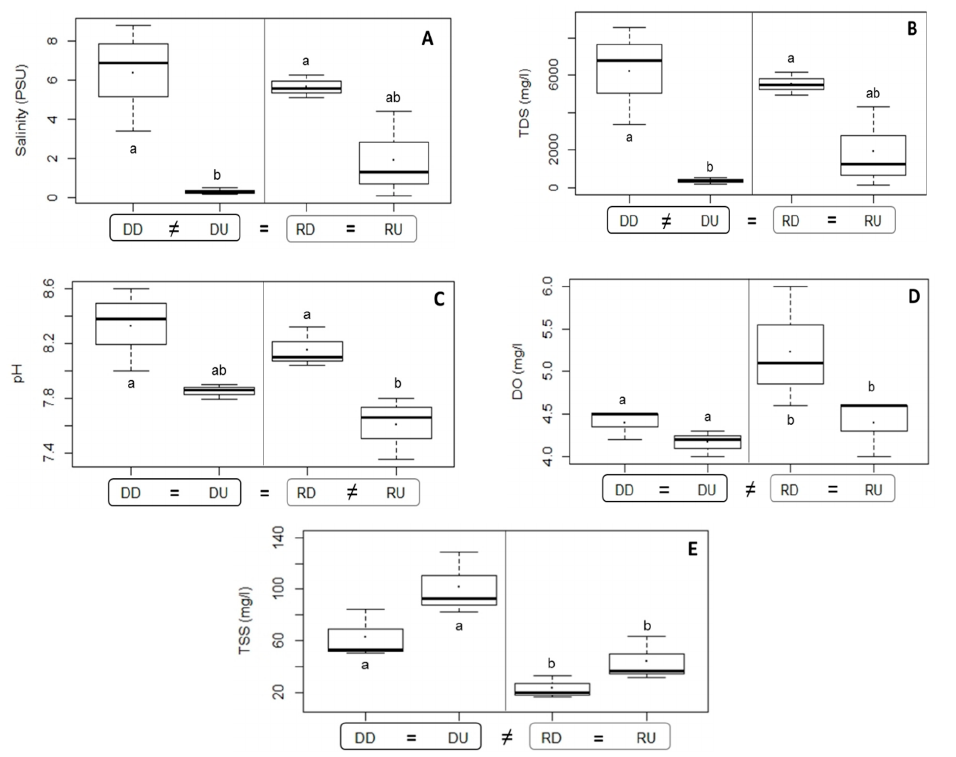
Figure 3. Box and whisker plots and mean values (.) for heavy metals including Fe ( A ), Cu ( B ), Cr ( C ), Hg ( D ), Se ( E ), Pb ( F ), As ( G ), Cd ( H ), H 2 S ( I ) and CH 4 ( J ) concentration in sediment of the estuarine sections. point to estuary level. Abbreviations: “DD” = dammed downstream, “DU” = dammed upstream, “RD” = reference downstream, “RU” = reference upstream. Letters a, b and c refer to signi fi cant di ff erences. “ ≠ ” sign indicated for the significant differences between 2 estuaries or/and estuarine sections within an estuary, while “=” sign meant that no significant difference was found.